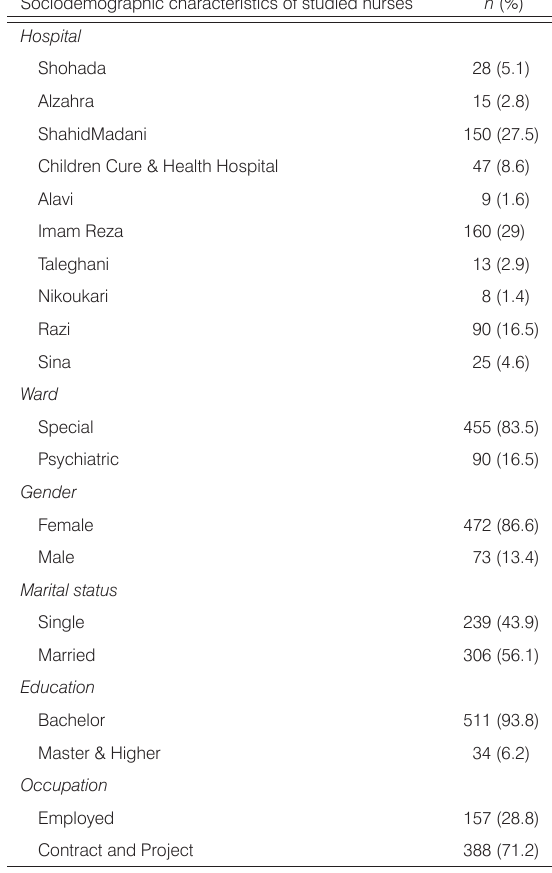
Table 2. The sociodemographic characteristics of studied